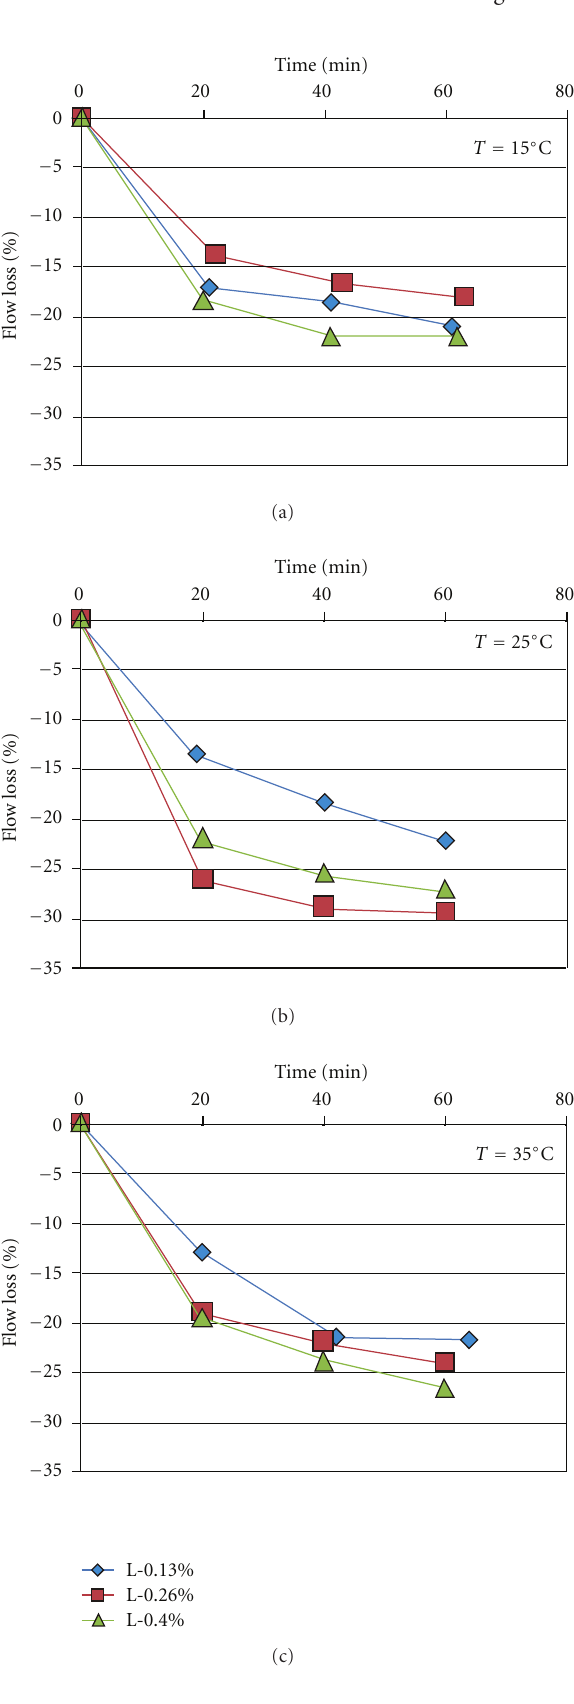
Figure 6: E ff ect of admixture dosage on flow